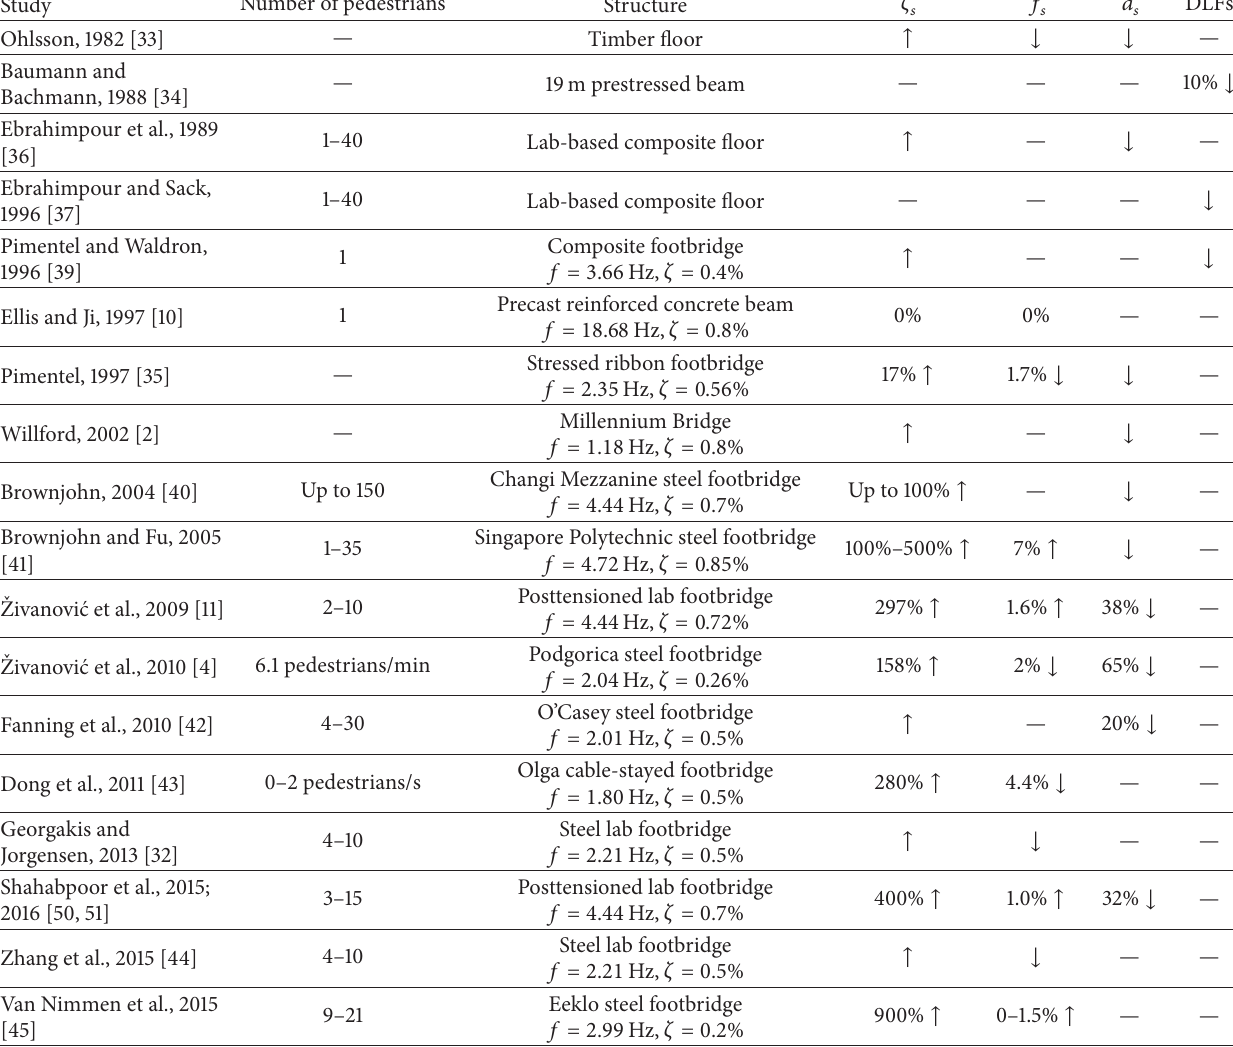
Table 2: Experimentally measured effects of HSI on modal properties of